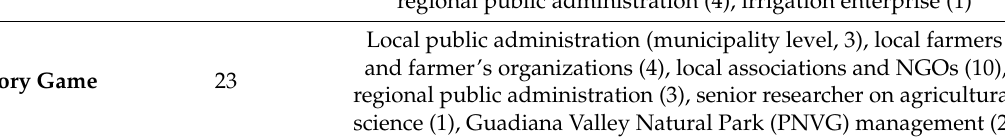
Sectors That Territorial Actors Represent